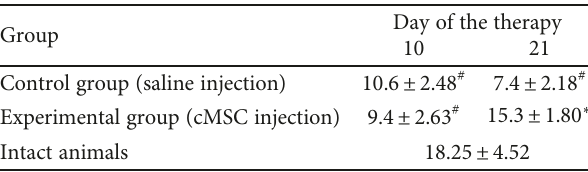
Table 2: The average number of follicles in the ovaries.